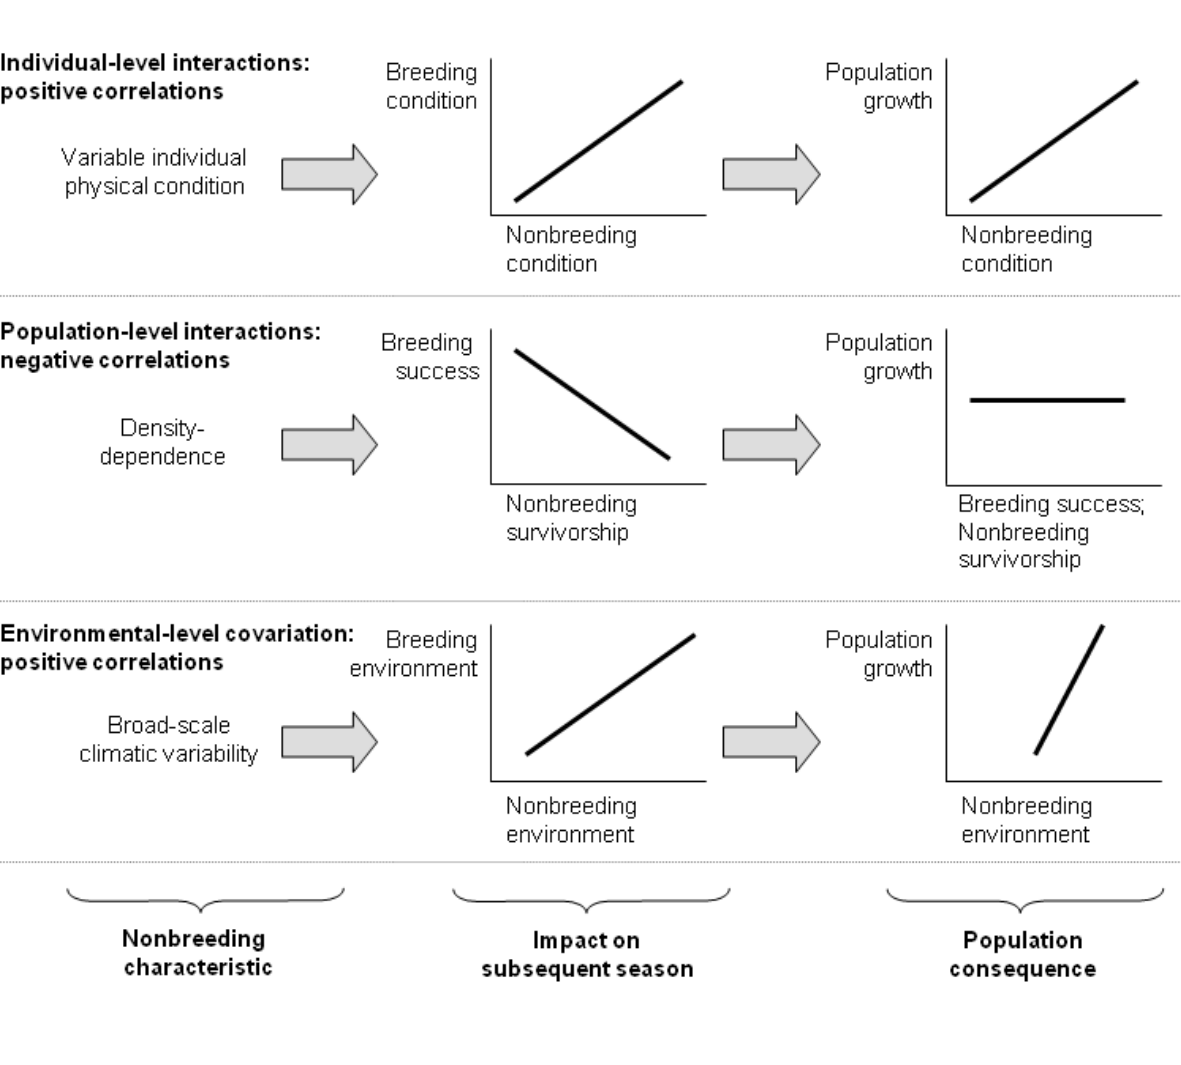
Fig. 3. Three levels of cross-seasonal nonbreeding influences upon population dynamics of seasonal migrants, illustrating the required nonbreeding characteristic, the subsequent season impact, and the consequences for population growth; linear relationships are assumed for simplicity, and each level is presented independently from others (i.e., without accounting for potential interactions among levels).